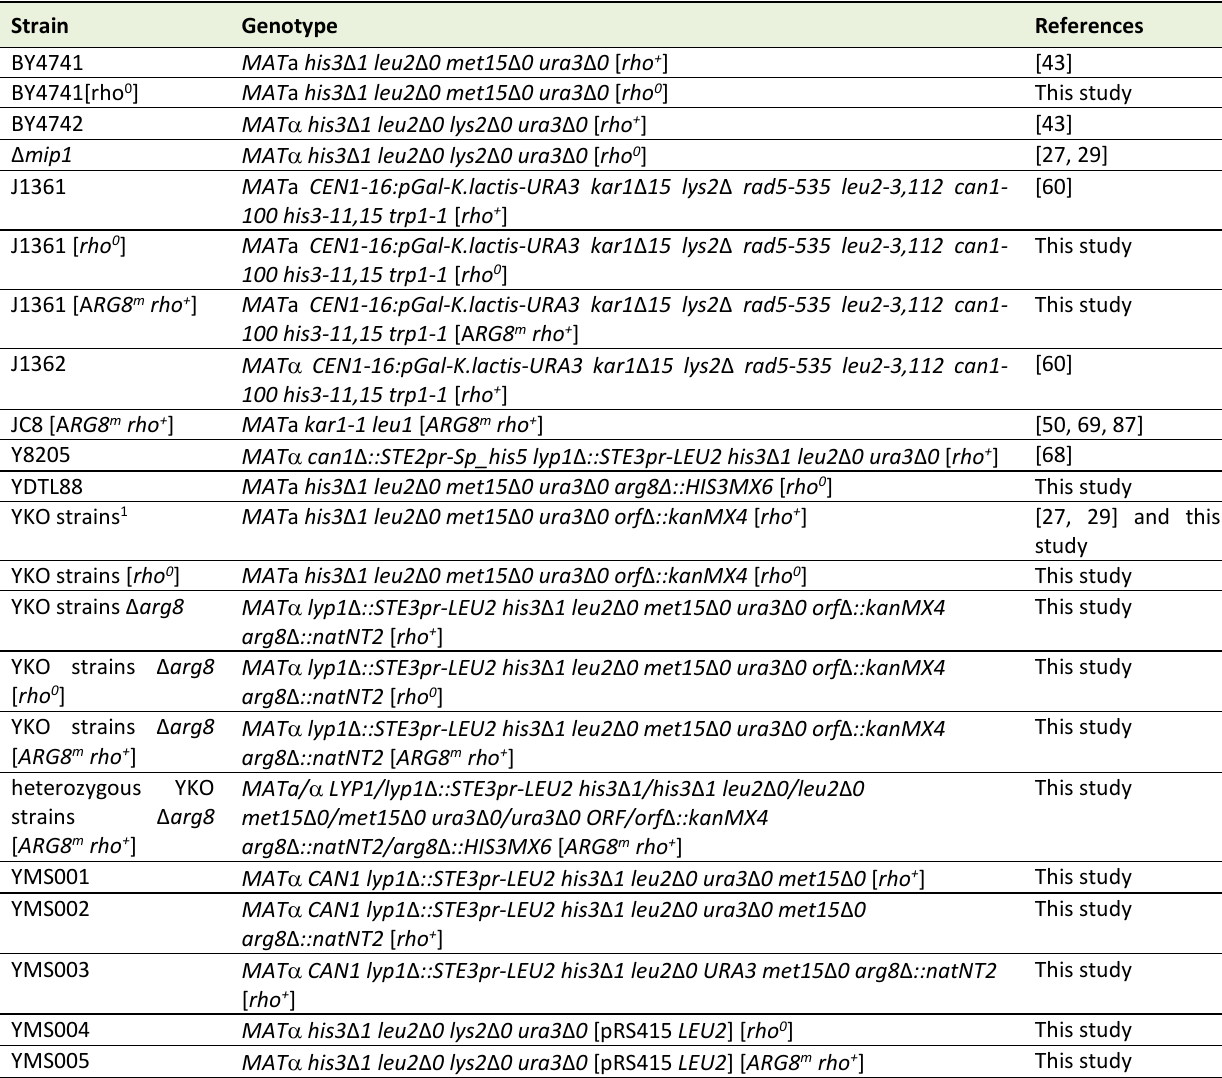
TABLE 5. Yeast strains used in this study. Strain Genotype